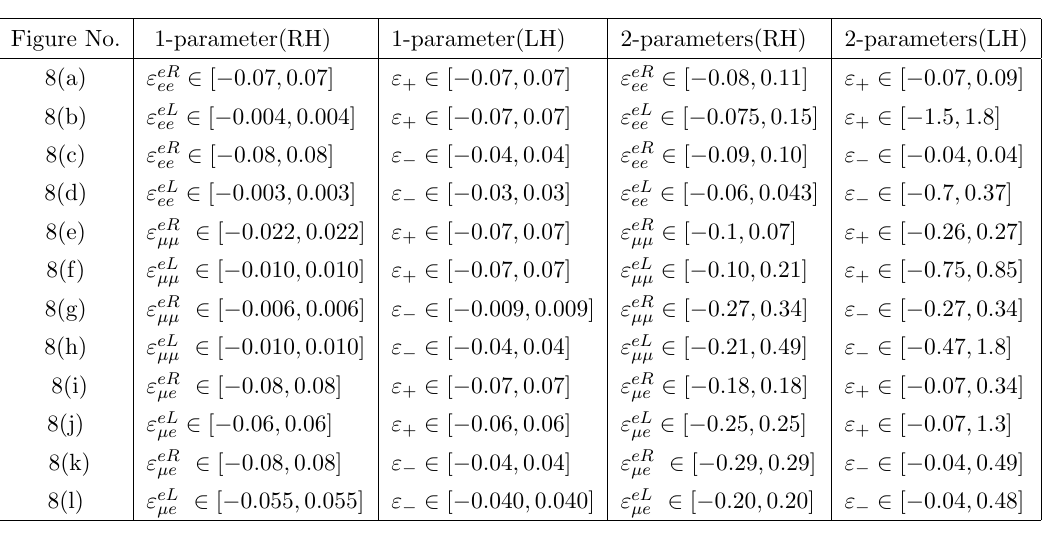
Table 6 . Future prospects: parameter bounds from the source and detector correlation study. In each entry where (cid:22) appears, (cid:28) can be substituted with the same range of values for the bounds. Both 1-parameter and 2-parameter bounds are given here at the 90%